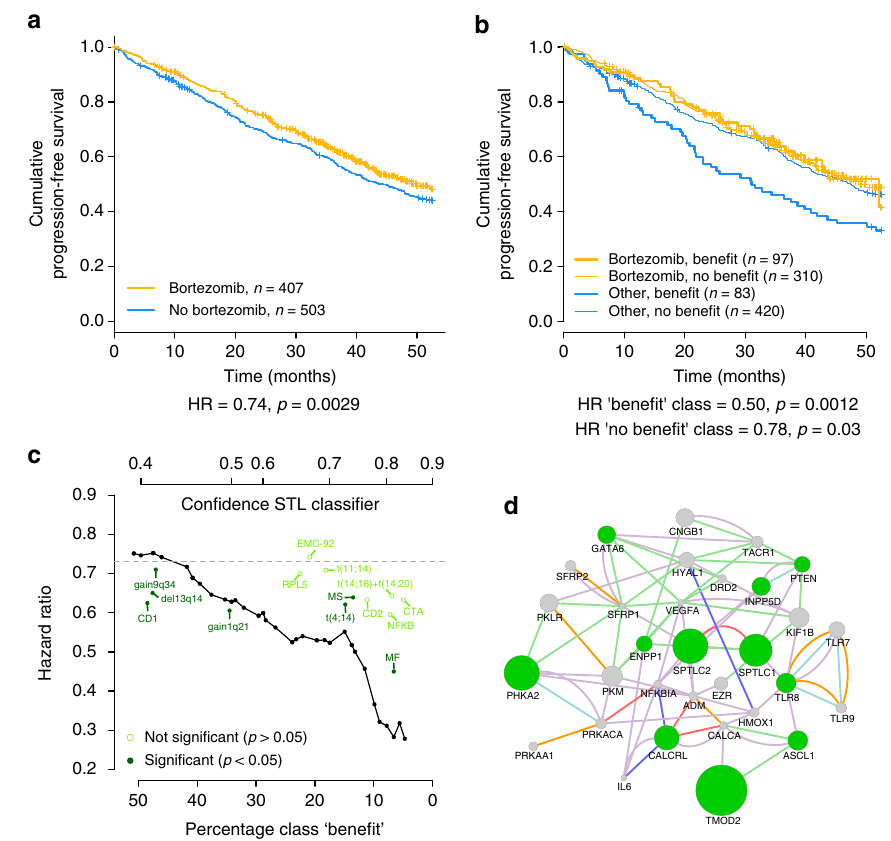
Fig. 2 Overview of the bortezomib classi fi er results and comparison to known markers. a Kaplan – Meier of the entire bortezomib dataset, showing a HR of 0.74 (95% CI: 0.61 – 0.90, p = 0.0029, n = 910), between the treatment arms. b Kaplan – Meier of the combined classi fi cations into a “ bene fi t ” and “ no bene fi t ” class of D1 – D3. A HR of 0.50 (95% CI: 0.32 – 0.76, p = 0.0012, n = 180) is found between the treatment arms in the “ bene fi t ” class and a HR of 0.78 (95% CI: 0.63 – 0.98, p = 0.03, n = 730) in the “ no bene fi t ” class. These results show that a subgroup, comprising 19.8% of the population ( n = 180 out of 910 total), is identi fi ed by our method that bene fi ts substantially more from bortezomib treatment than the population as a whole; in the entire population an HR of 0.74 (95% CI: 0.61 – 0.90, p = 0.0029, n = 910) is found. c The HR found in the “ bene fi t ” class ( y -axis) when different operating points ( x -axis) are used, compared with known predictive and prognostic markers. The gray dotted line indicated the HR found in the entire dataset, without classi fi cation. d Relationships between the 31 genes in common between the D1 – D3 classi fi ers. Node size corresponds to how much more a gene was observed in the selected gene sets than expected. Green nodes indicate that the gene is associated with a p < 0.05. Relationships are inferred from literature with the GeneMANIA 41 algorithm. A purple edge indicates the genes are co-expressed, a green edge indicates a genetic interaction, a red edge a physical interaction, an orange edge a shared protein domain, a dark blue edge indicates colocalization and a light blue edge shows that both genes are annotated to the same